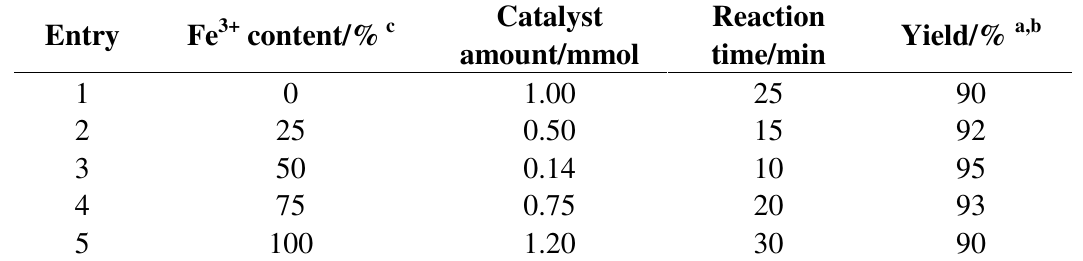
Table 2. The effect of the Fe 3+ content on the catalytic activities.